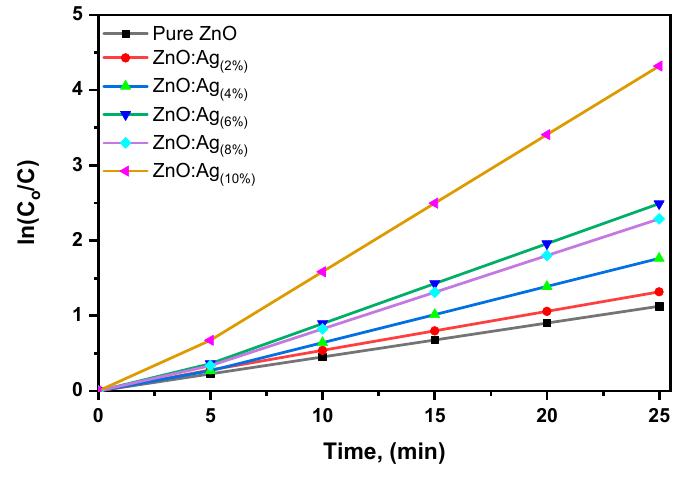
(cid:16) (cid:17) ) versus time plot to determine the rate of constant. Figure 12. ln ( (cid:3004) (cid:3290) C o Figure 12. ln versus time plot to determine the rate of constant. (cid:3004) C Table 3. Comparison between efficiencies of different catalyst systems with previous